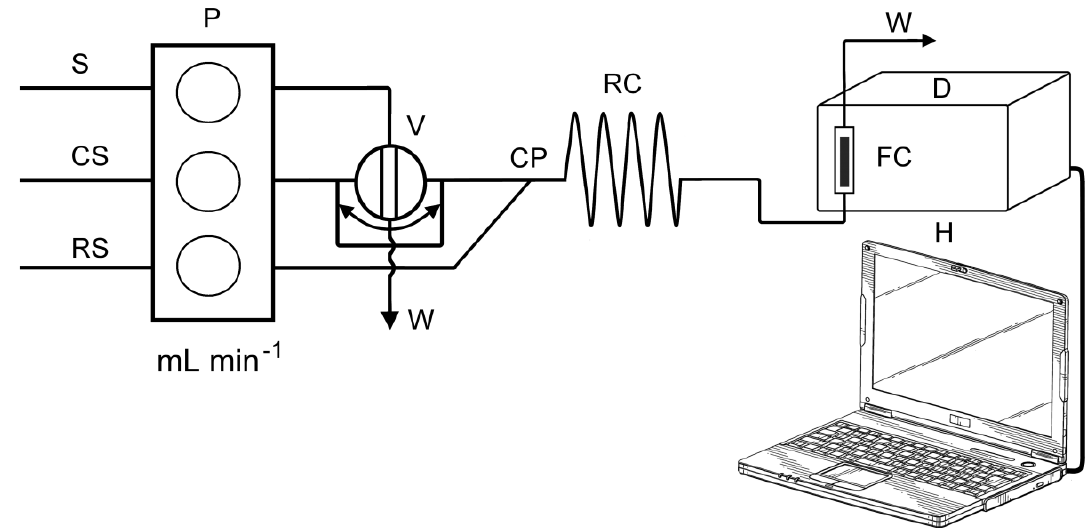
Figure 2. Schematic diagram of the flow injection manifold: S—standard solution, CS—carrier (ultra pure H 2 O), RS—reagent (reagents depends on the ligand), P—peristaltic pump, V—injector valve (loop = 500 µL), CP—confluence point, RC—reaction coil (i.d. = 0.8 mm), D—spectrophotometric detector equipped with flow cell (FC), (VFC = 160 µL), H—computer, W—waste.